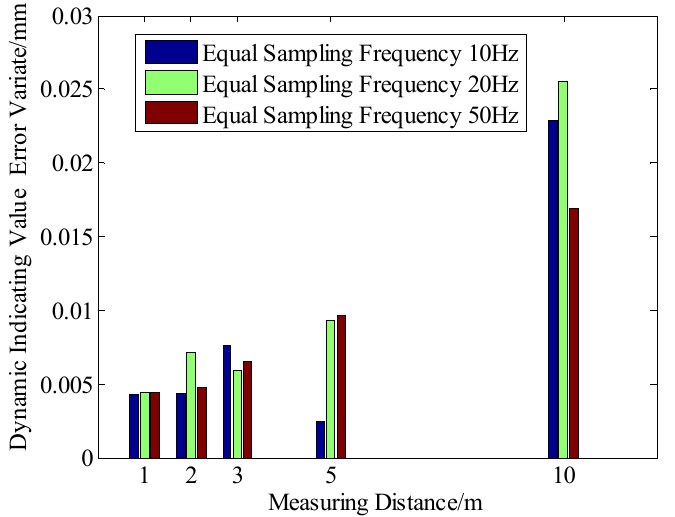
Figure 11. Measurement distance and dynamic display value variable relationship diagram—(equal sampling frequency).